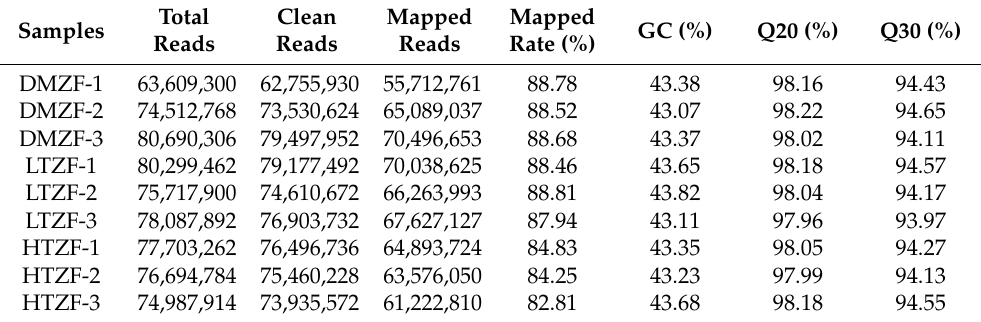
Table 2. Sequencing data from transcriptome analysis and quality